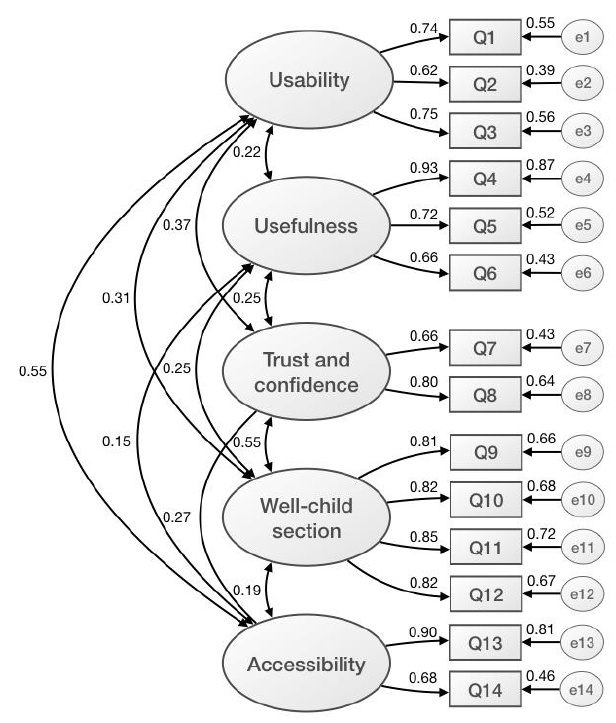
Figure 1. Measures of internal consistency of the construct by a confirmatory factor analysis (maximum likelihood estimation method).